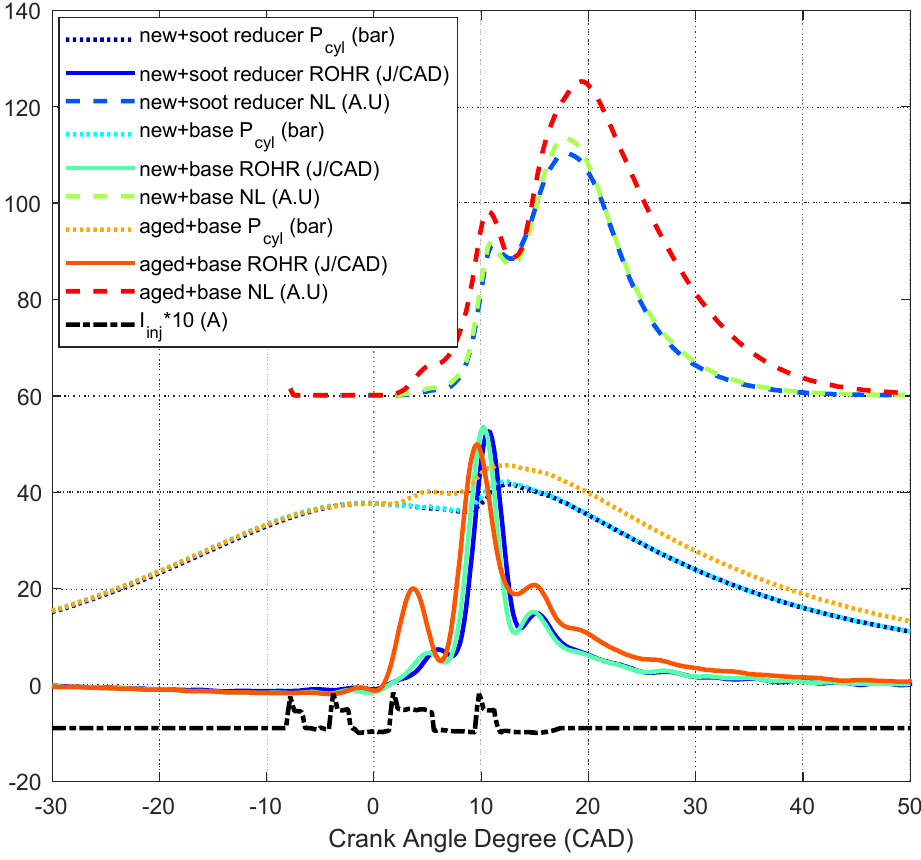
Figure 18. Pressure, heat release rate and spatial integration of natural luminosity signal during combustion at low load.